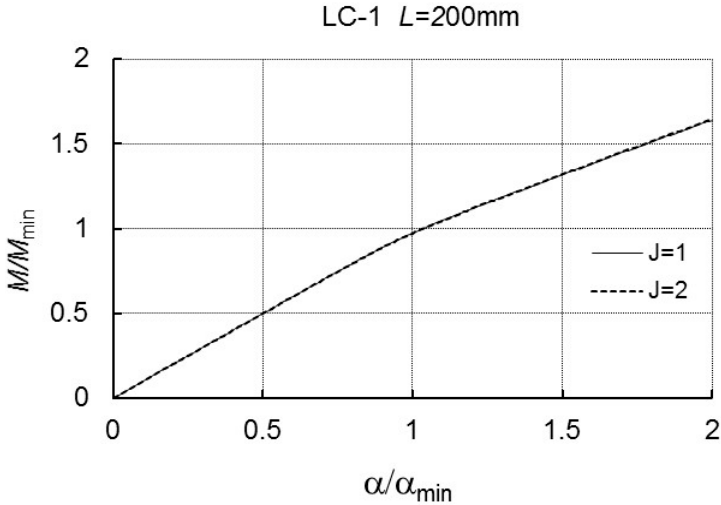
Figure 4. M / M min as a function of α / α min for LC-1 and L = 200 Figure 4 . M/M m in as a function of α / α min for LC-1 and L = 200 mm.